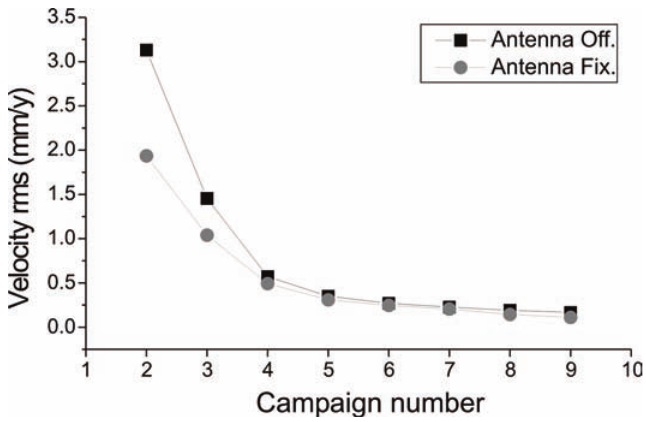
Figure 4. Mean velocity rms from the simulation of 7-day yearly campaigns with antenna installation errors (antenna